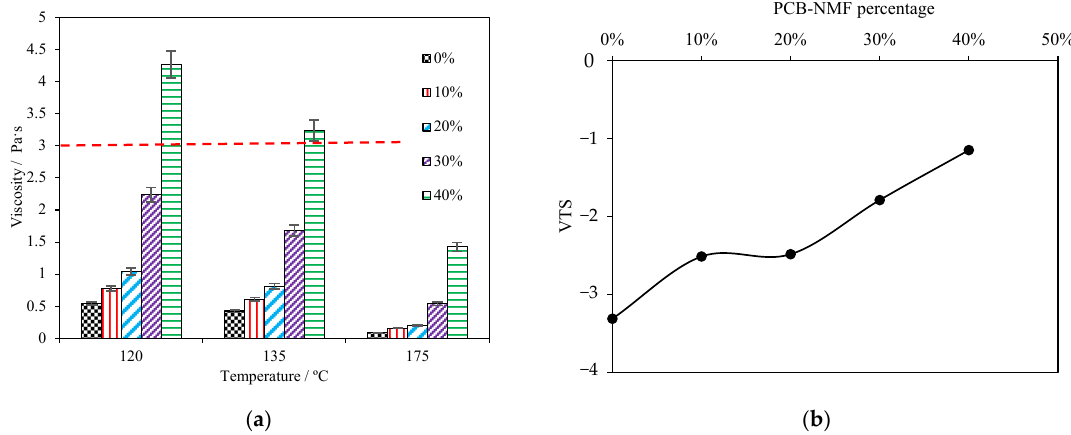
Figure 6. Viscosity and VTS of asphalt with different PCB-NMF contents: ( a ) viscosity, ( b ) VTS.